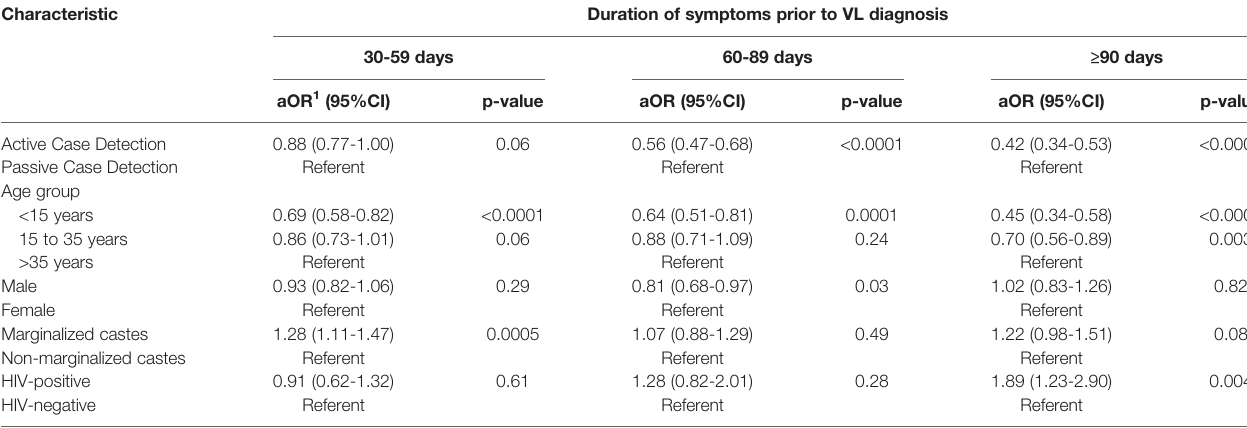
Eighty-nine patients with data missing for one or more variables are excluded from the model. Time intervals of 30-59, 60-89 and ≥ 90 days are compared to diagnosis <30 days after onset. 1 Odds ratio adjusted for all listed variables.